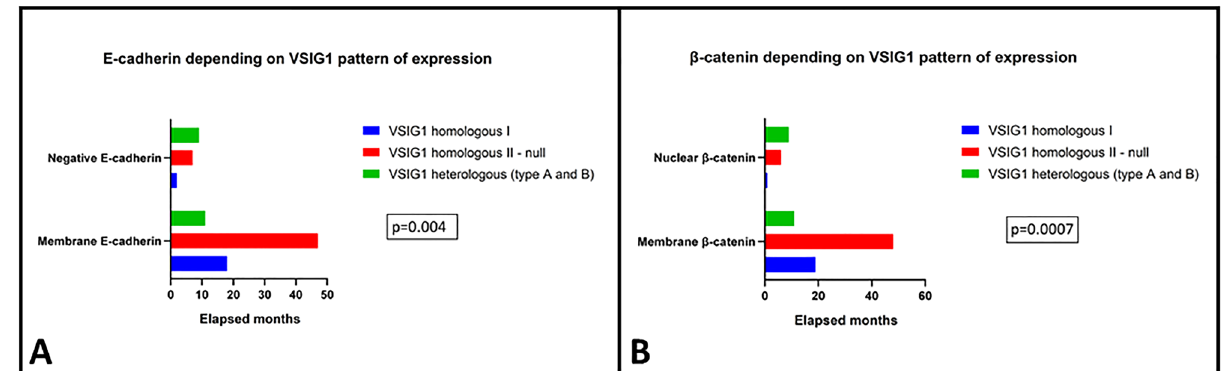
Figure 3. Tumors with homologous patterns of VSIG1 expression are more commonly characterized by double E-cadherin ( A ) and β-catenin membrane positivity ( B ) which reflects an epithelial molecular subtype and absence of epithelial–mesenchymal